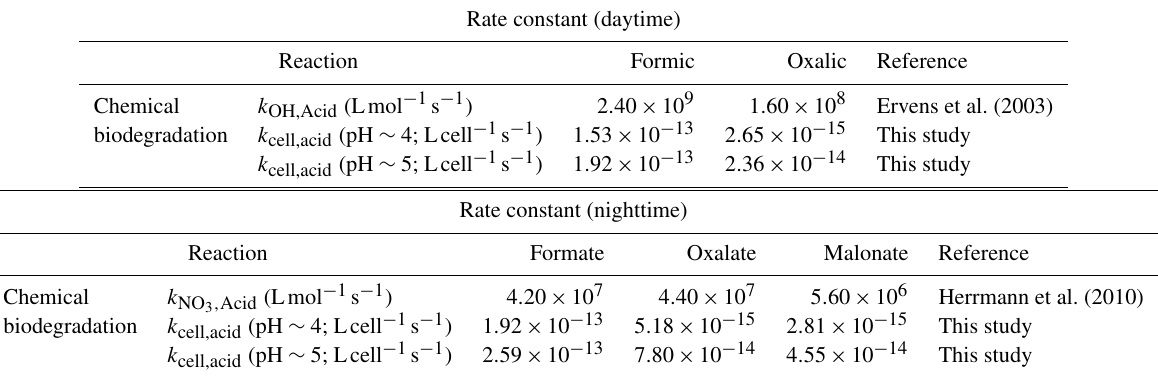
Table 1. Rate constants used to estimate the loss rates by biodegradation and chemical reactions (i.e., for